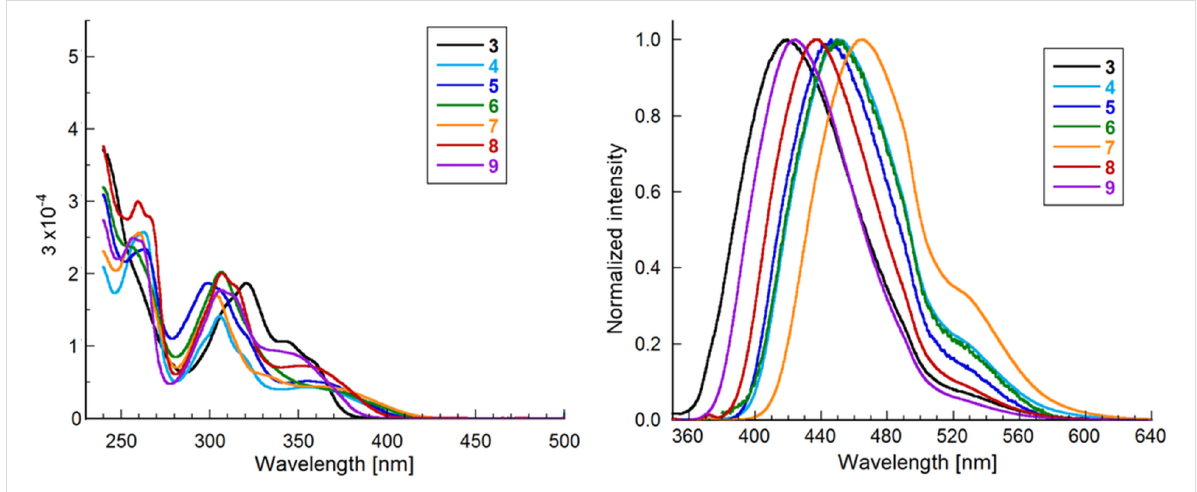
Figure 3: UV–vis absorption (left) and normalized fluorescence emission (right, excitation at 335 nm) spectra in CH 2 Cl 2 .